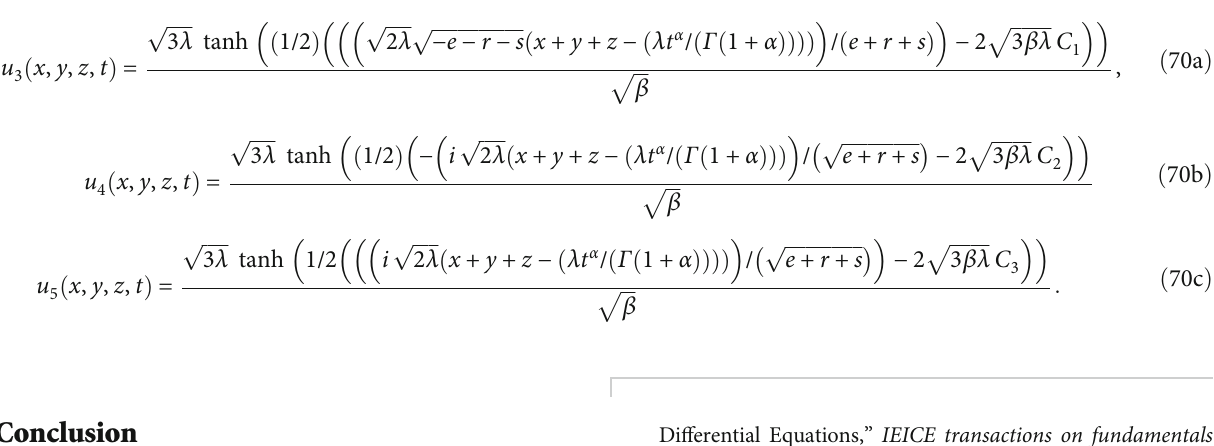
ffiffiffiffiffiffiffiffiffiffiffiffiffiffiffi ffiffiffiffiffiffiffiffi